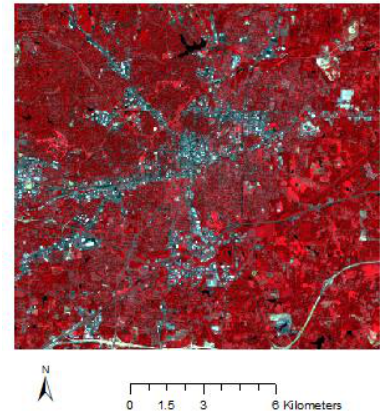
Figure 7. The study area shown in 4/3/2 combination, Greensboro, North Carolina, USA. UL/LR (X,Y):